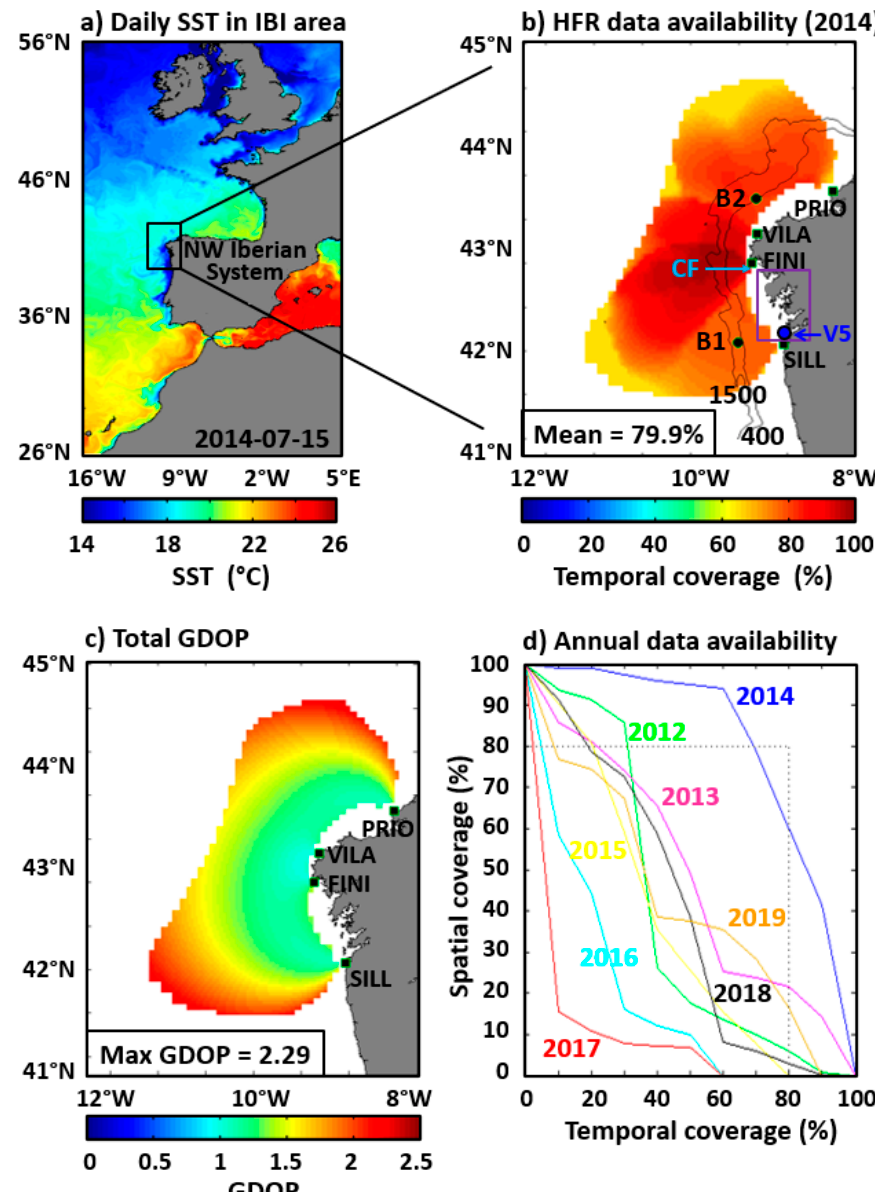
Figure 1. ( a ) Daily sea surface temperature (SST) for the 15th of July 2014, as predicted by the Iberia–Biscay–Ireland (IBI) forecast system. Northwestern (NW) Iberian upwelling system denoted by the black box. ( b ) Temporal availability (%) of high-frequency radar (HFR) hourly data for 2014. Locations of Silleiro (B1) and Vilano (B2) buoys and four radar sites (Silleiro (SILL), Finisterre (FINI), Vilán (VILA) and Prior (PRIO)) are marked with a filled dot and squares, respectively. HFR network jointly managed by INTECMAR and Puertos del Estado. CF (in light blue) represents the Cape Finisterre promontory. Rías Baixas denoted by the purple box, with one tiny dark blue dot inside representing a Conductivity–Temperature–Depth (CTD) station (V5). Bathymetric contours show depths at 400 and 1500 m. ( c ) Spatial distribution of the Geometric Dilution of Precision (GDOP) for the geometry of the Galician HFR system. ( d ) Annual availability of HFR data: spatial coverage versus temporal coverage. Black dotted lines represent the recommended 80–80% level of data provision.